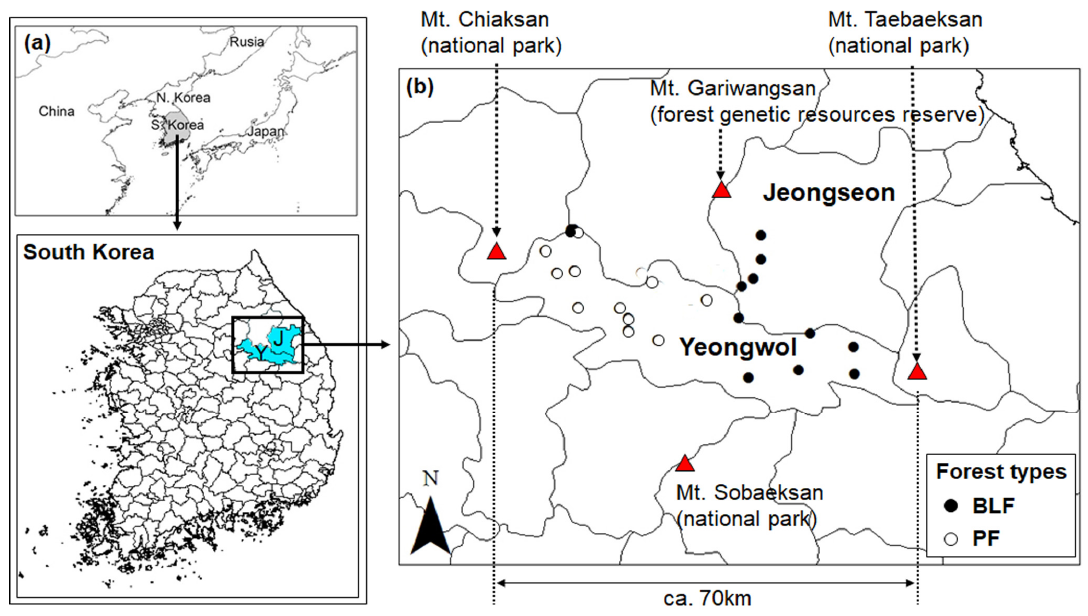
Figure 1. Map of ( a ) study area and ( b ) study sites (filled circle, broad-leaved deciduous forests (BLF); opened circle, Pinus densiflora forests (PF)).